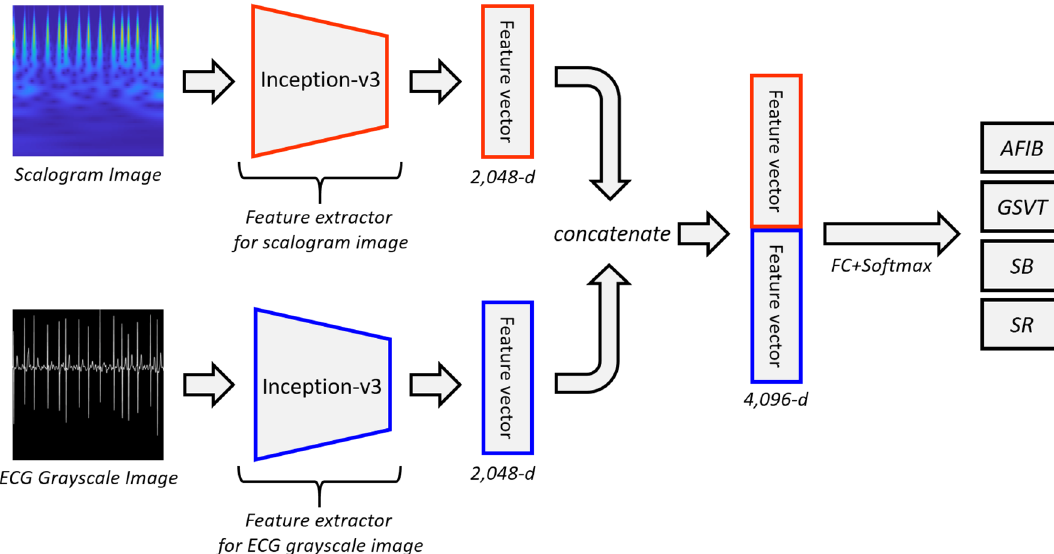
Figure 2. Proposed bimodal CNN model architecture. Grayscale images and scalograms are fed to identical Inception-v3 models simultaneously. Output features of the two Inception-v3 are concatenated and fed into a fully connected classification layer with a softmax activation function that outputs prediction values in the range of 0–1 for the 4 labels. CNN models